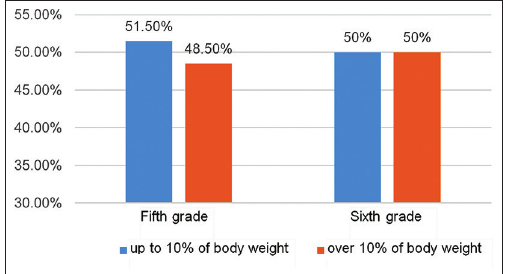
FIGURE 3. The percentage of students in each grade in relation to the weight of schoolbag (%), i.e., ≤10% or >10% of the body mass. TABLE 7. Schoolbag weight (%) in relation to feeling of tiredness Schoolbag‑related feeling of tiredness